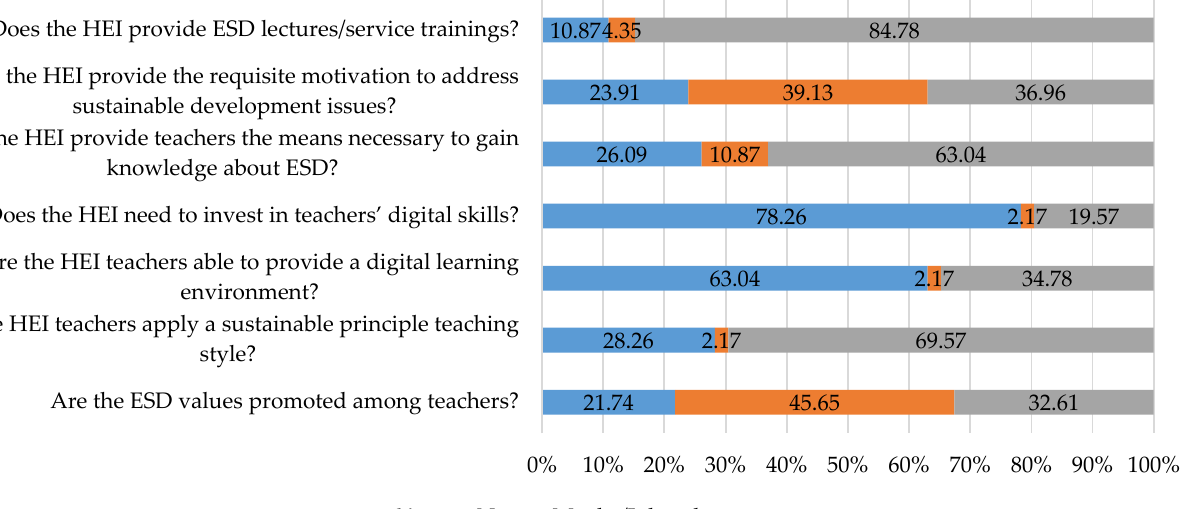
Figure 5. Priority area No. 3 results.